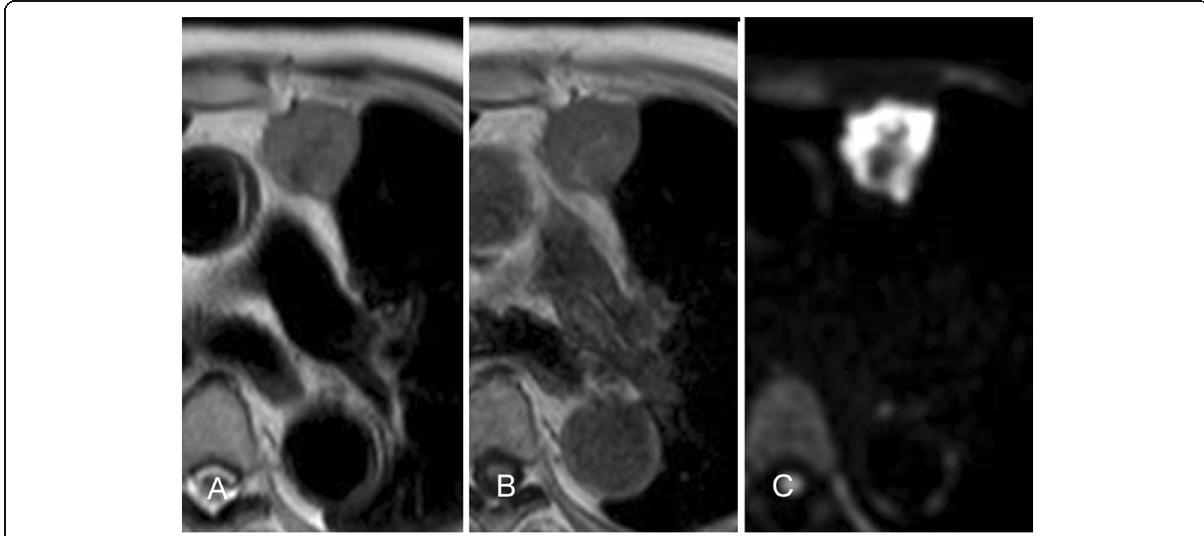
Fig. 2 MRI findings. MRI shows the iso-intensity mass on T1-weighted imaging ( a ) and high intensity on T2-weighted imaging ( b ). The marginal zone of the mass shows a low-density area with a refined lobulated structure. Diffusion-weighted image shows a high intensity area in the marginal zone with apparent diffusion coefficient sequences